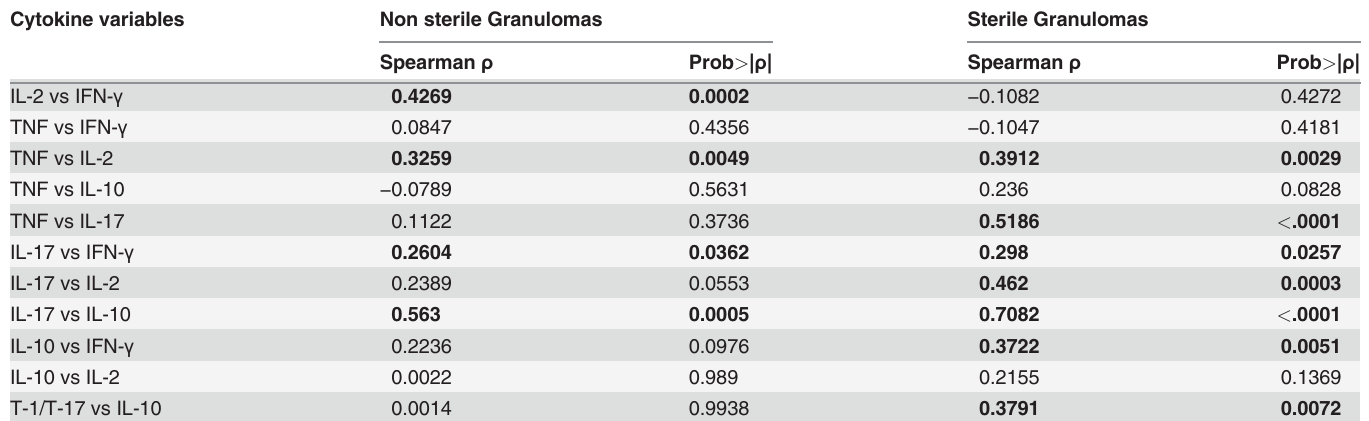
Table 1. Pairwise correlation of cytokine levels within granulomas based on bacterial